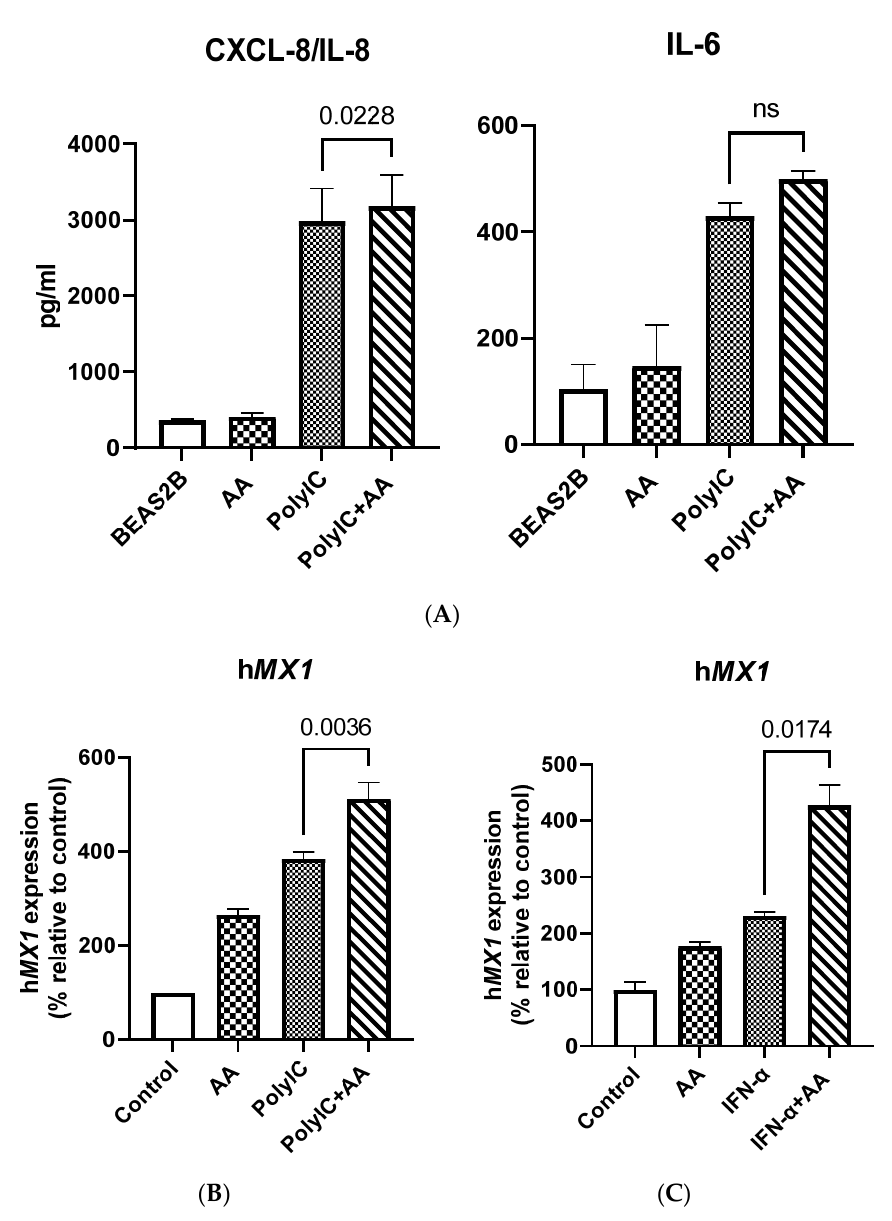
Figure 4. Vitamin C treatment enhances the response of BEAS-2B cells to the antiviral ligand poly I:C. ( A ) Bar graphs depict the levels of CXCL-8/IL-8 and IL-6 as determined by ELISA. ( B ) BEAS-2B cells were stimulated with poly I:C in the presence or absence of vitamin C for 24 h. Bar graph depicts the expression of the MX dynamin like GTPase 1 (MX1) gene. ( C ) BEAS-2B cells were stimulated with IFN- α in the presence or absence of vitamin C for 24 h. Bar graph depicts the expression of the MX1 gene. Data are means ± SE of at least 4 separate experiments.